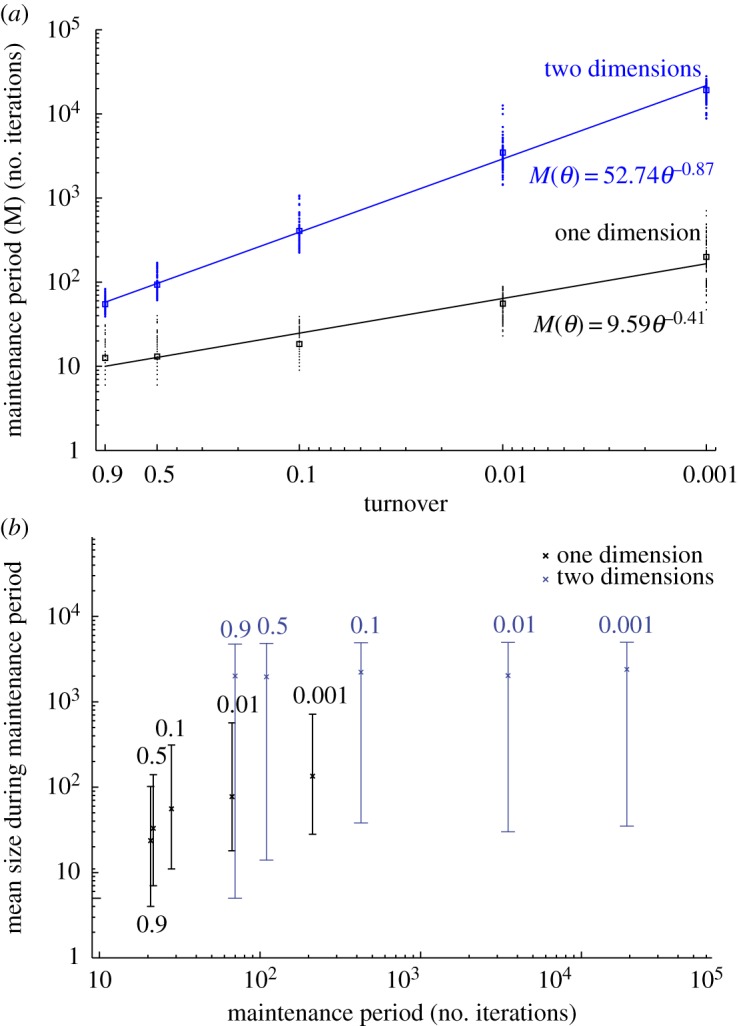
Maintenance period. (a) Mean number of iterations during the maintenance period, i.e. time between the iteration when the largest filament or cluster reaches its maximum size and the iteration when it reaches the stationary size. The iterations are plotted as a function of the turnover for one-dimensional (black) and two-dimensional (blue) simulations. The methodology to assess the iteration at which each simulation reaches stationary size is described in the Material and methods section. Each circle represents one run while squares represent the mean value over 100 sets of independent runs for the different turnovers in one and two dimensions. The data can be fitted with a power law (line), with scaling exponents −0.41 (one dimension) and −0.87 (two dimensions). (b) Size of the largest filament or cluster during the maintenance period as a function of the length of the maintenance period (number of iterations). The central mark shows the mean and the extremes represent the upper and lower limits of 95% of the data points. The variability of sizes in the graph reflects how the largest filament or cluster changes its size in each population during this period, as it starts with its maximum size and reaches its lowest size (stationary size).